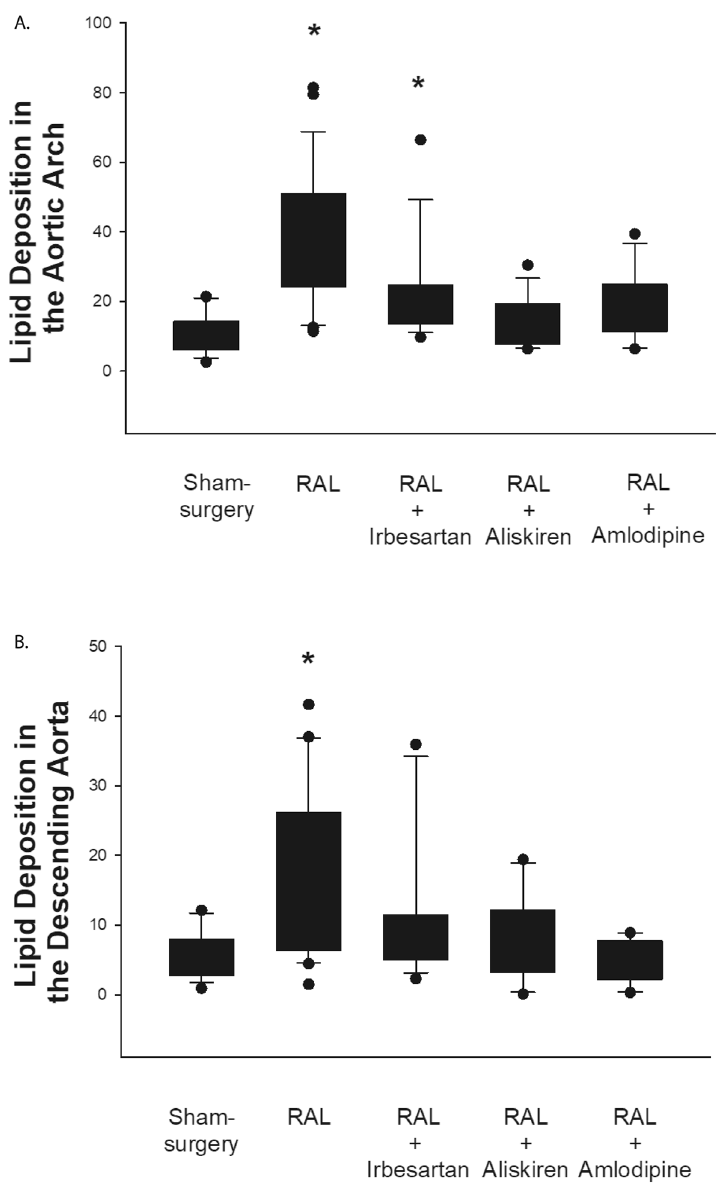
Figure 3. Lipid deposition in the descending aorta and aortic arch following renal artery ligation. The area of the aortic arch ( A ) or descending aorta ( B ) that stained with Oil-red-O as a percentage of total area for all mice in each of the groups. [* p < 0.05 vs